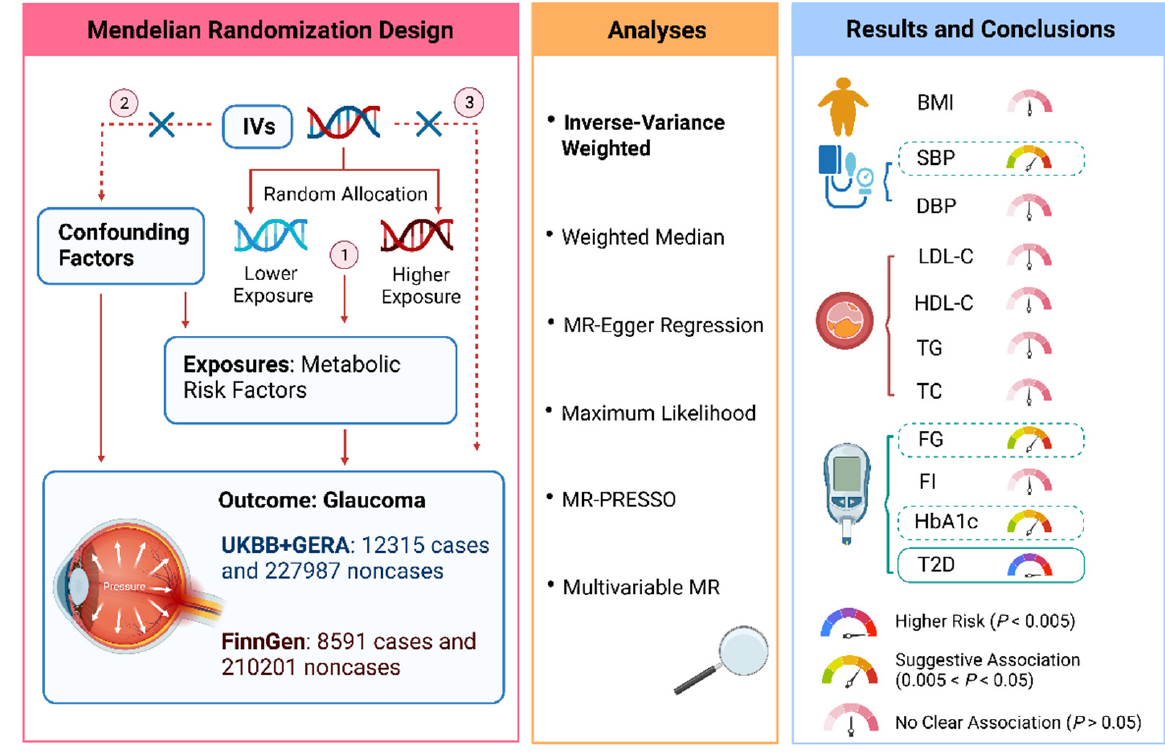
Figure 1. Overview of the MR study design and results. The validity of MR findings depends on the three crucial assumptions, i.e., the instrumental variables should be robustly associated with the exposure of interest (assumption 1) and not be associated with potential confounders (assumption 2) and affect the outcome only through the intermediate exposure, not through others pathways (assumption 3). To satisfy these assumptions, in addition to the main analysis (the inverse variance- weighted method), we also used multiple MR approaches as sensitivity analyses to detect and correct for pleiotropy. Abbreviations: BMI, body mass index; DBP, diastolic blood pressure; FG, fasting glucose; FI, fasting insulin; HbA1c, hemoglobin A1c; HDL-C, high-density lipoprotein cholesterol; IVs, instrumental variables; LDL-C, low-density lipoprotein cholesterol; SBP, systolic blood pressure; T2D, type 2 diabetes; TC, total cholesterol; TG, triglyceride; UKBB, UK